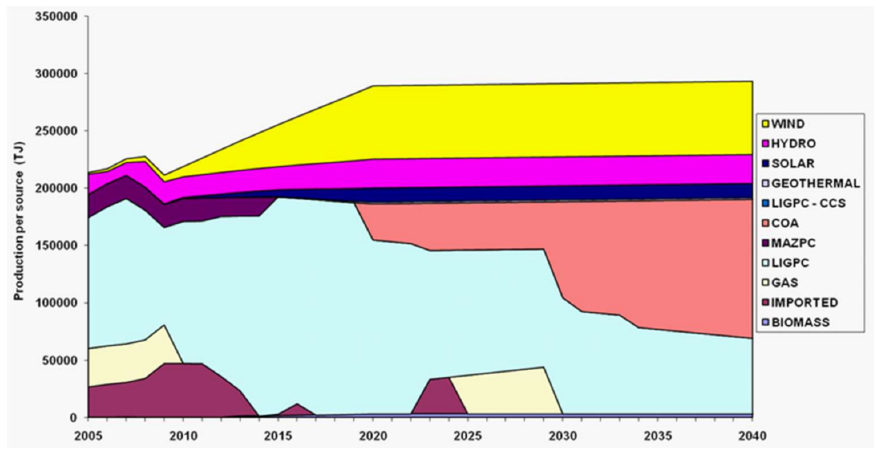
Figure 13. Electricity power generation by technology groups according to the BAU